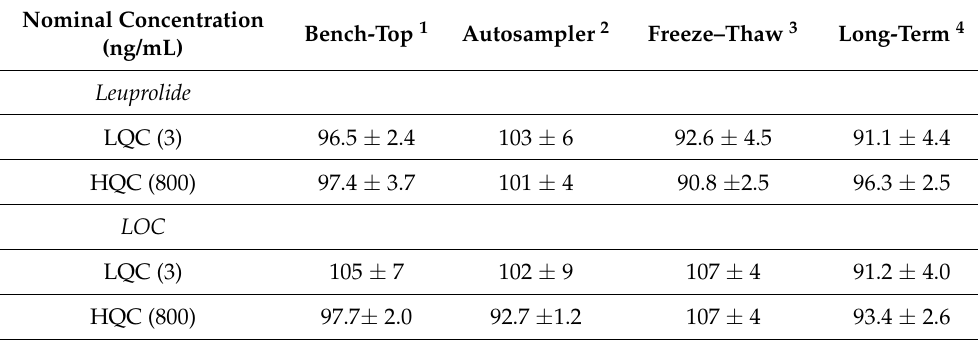
Table 2. Stability (as the percentage of drug remaining) of leuprolide and leuprolide-oleic acid conjugate (LOC) in rat plasma samples ( n =